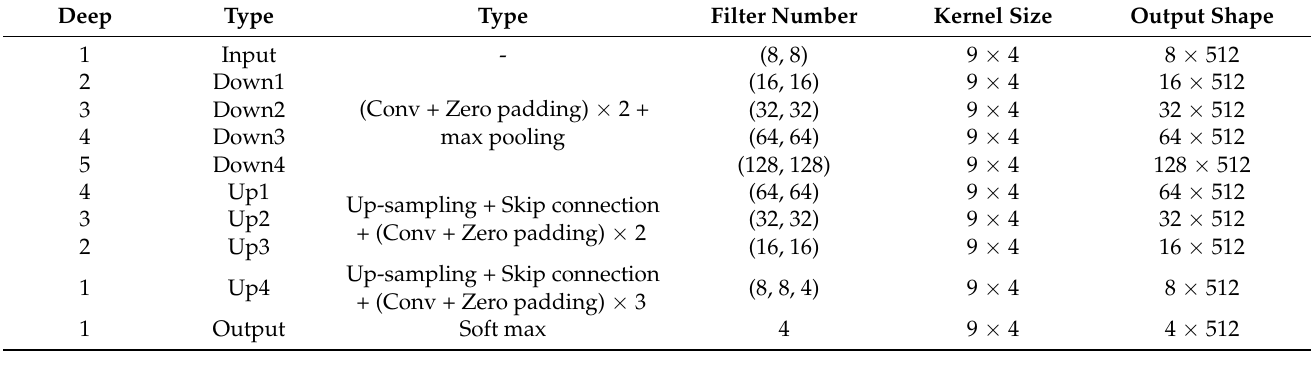
Figure 10. Experimental results under different parameters: ( a ) Results under different fixed lengths; ( b ) Results under different optimizers; ( c ) Results under different network depths; ( d ) Results under different convolution kernel sizes.